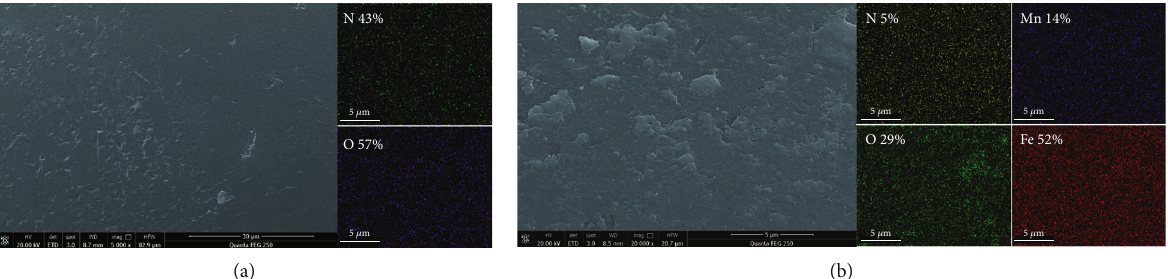
Figure 3: SEM image and mapping of D201 and MnFe